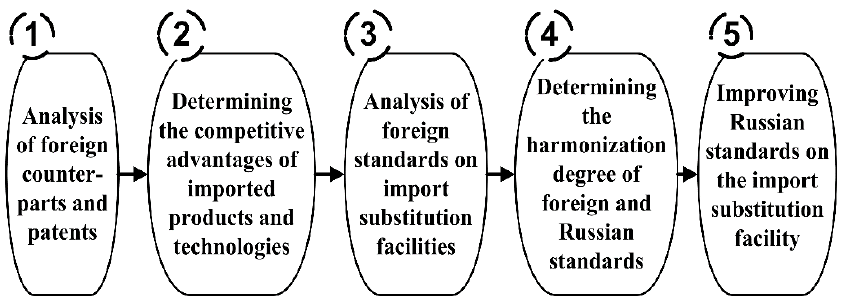
Figure 2. Stages of improving the standardization